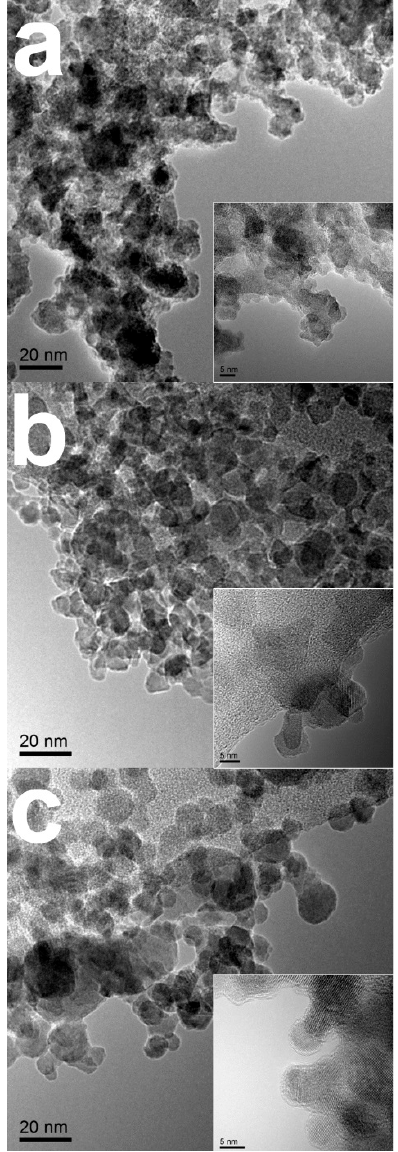
Figure 1. Transmission electron microscopy (TEM) images of ( a ) PBC; ( b ) PBCF82; and ( c ) PBCF55. Each inset shows high-resolution TEM images revealing fringes.